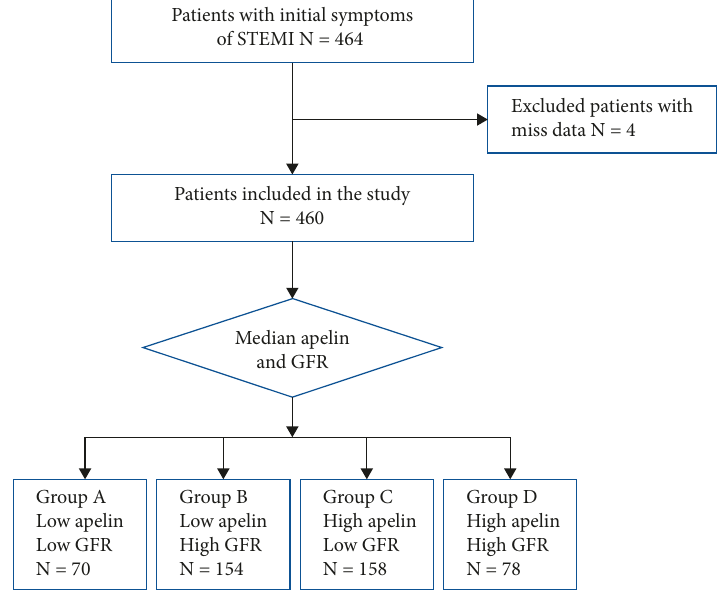
Figure 1: Flow chart of the